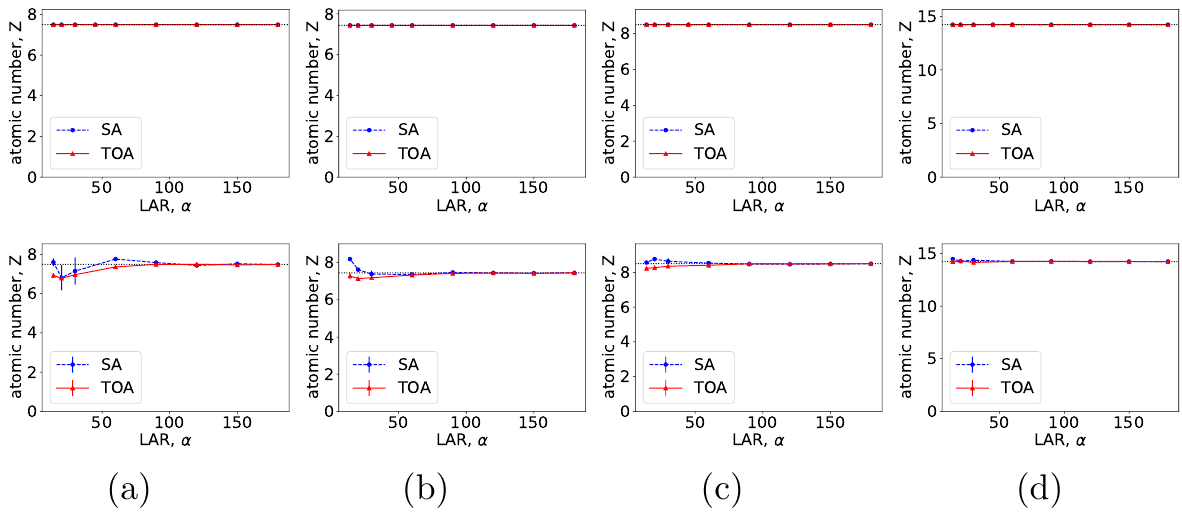
Figure 11. Effective atomic numbers of ( a ) water, ( b ) ANFO, ( c ) Teflon, and ( d ) PVC, along their respective error bars, within the suitcase phantom estimated as functions of LAR α τ for SA (blue, dashed) and TOA (red, solid) scans, computed from basis images reconstructed from noiseless (row 1) and noisy (row 2) data by use of the two-step